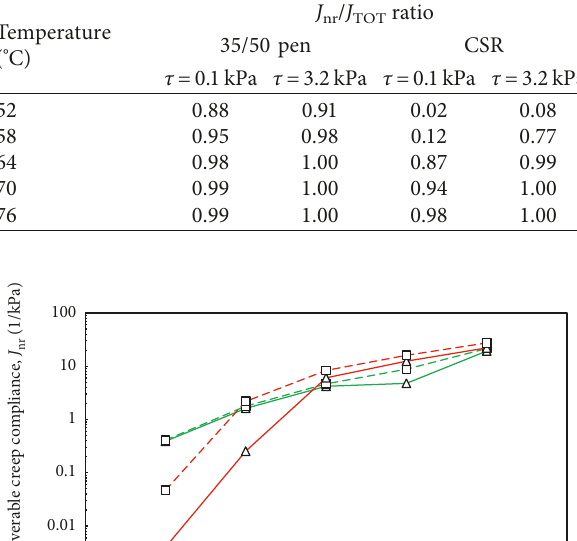
Table 5: MSCR test results— J Temperature